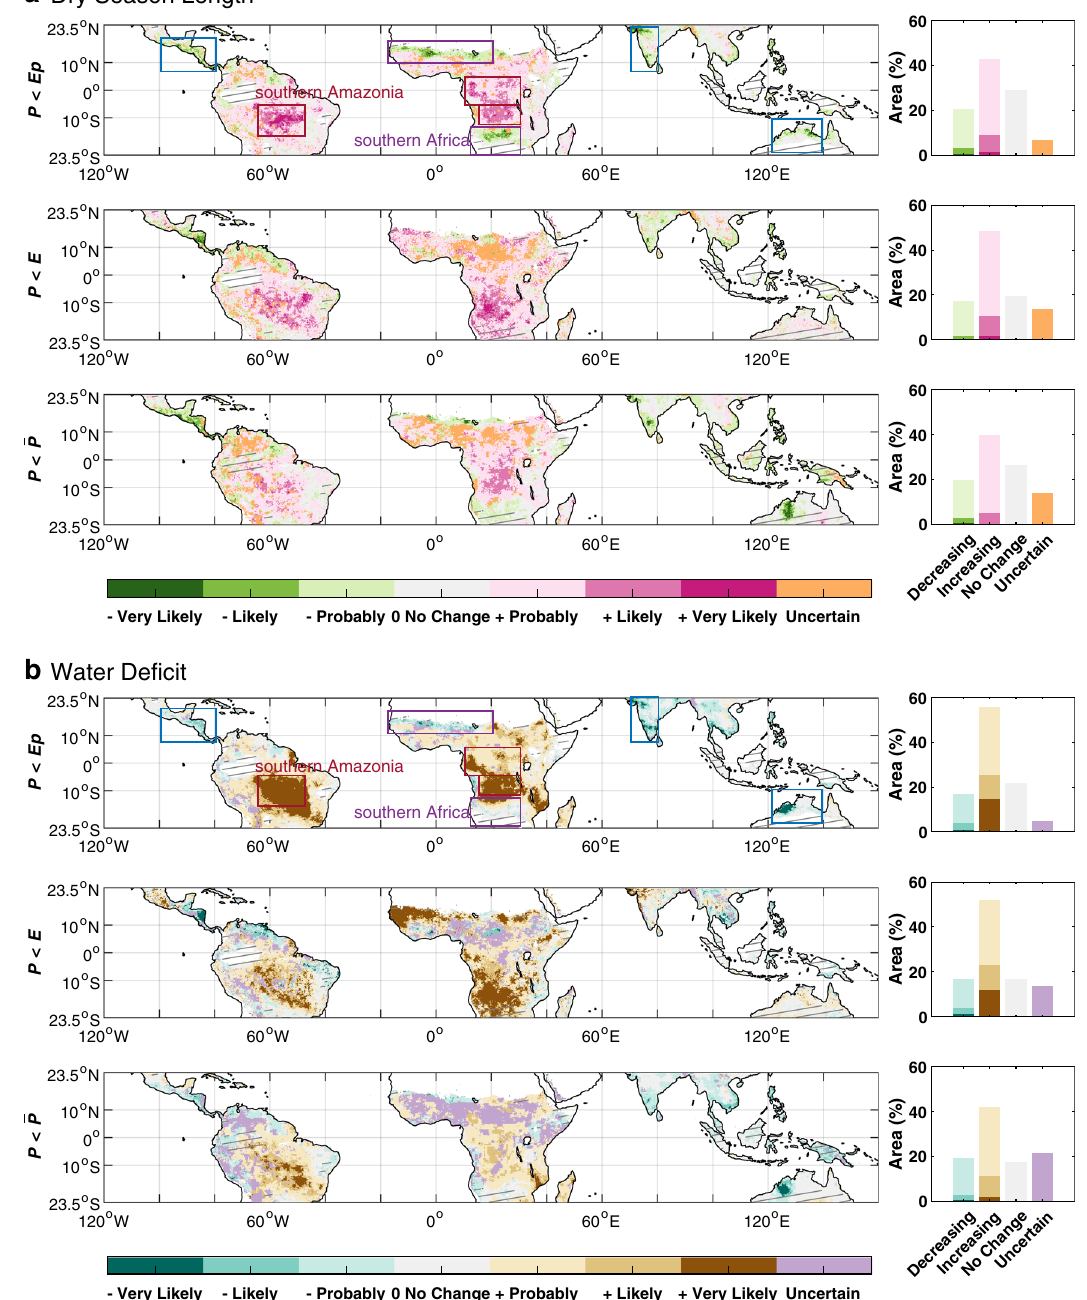
Fig. 4 Consistency of trends in dry season length and water de fi cit for each de fi nition, from eight datasets (1983-2016). The consistency of trends in dry season length ( a ) and water de fi cit ( b ) under each of the three de fi nitions of “ dry season ” was assessed as the variation among the eight precipitation datasets. “ Very likely ” , ‘ Likely ” and “ Probably ” indicate that the sign of the trend was the same and signi fi cant in 6 – 8, 4 – 5, and 1 – 3 precipitation datasets, respectively, while the other datasets showed no signi fi cant change. “ Uncertain ” indicates con fl icting trends among datasets, with some showing a signi fi cant increase and some showing a signi fi cant decrease. “ No Change ” indicates that all eight datasets showed no signi fi cant change. The histograms in the right column of a and b show the percent area with consistent increase or decrease trends. Arid and humid regions (solid gray shaded area) were excluded when calculating the percent area, since there was no climatologically wet or dry season, thus no trends calculated under de fi nitions of P < Ep or P < E . This analysis combined both dry seasons for regions with two dry seasons (individual trends for each distinctive season are shown in Supplementary Fig. 9). Consistency of trends in dry season length and water de fi cit for the other two Ep products (MERRA-2 and GLDAS-v2.0) based on P < Ep de fi nition were shown in Supplementary Fig.